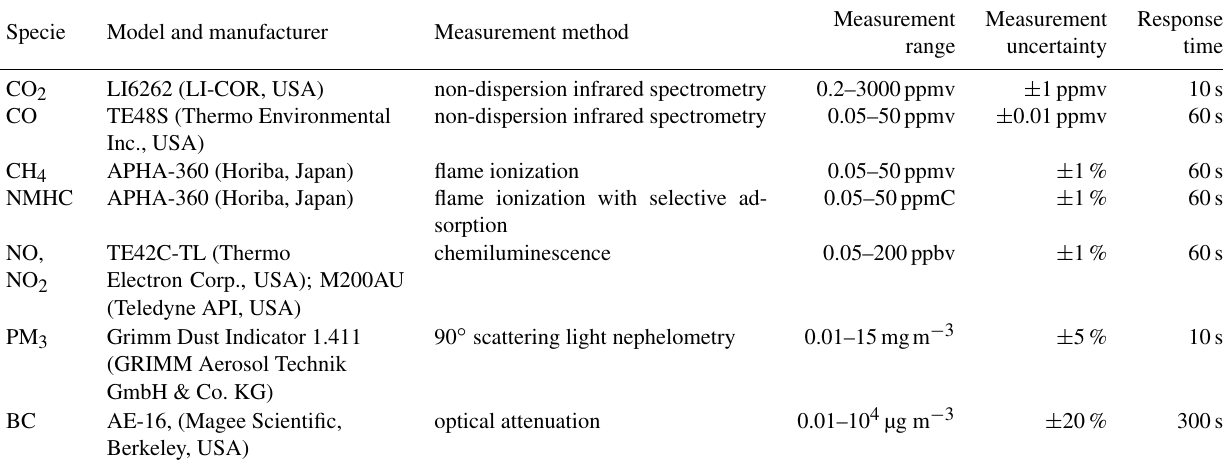
Table 2. Instruments used for trace gas and aerosol measurements in TROICA expeditions. Specie